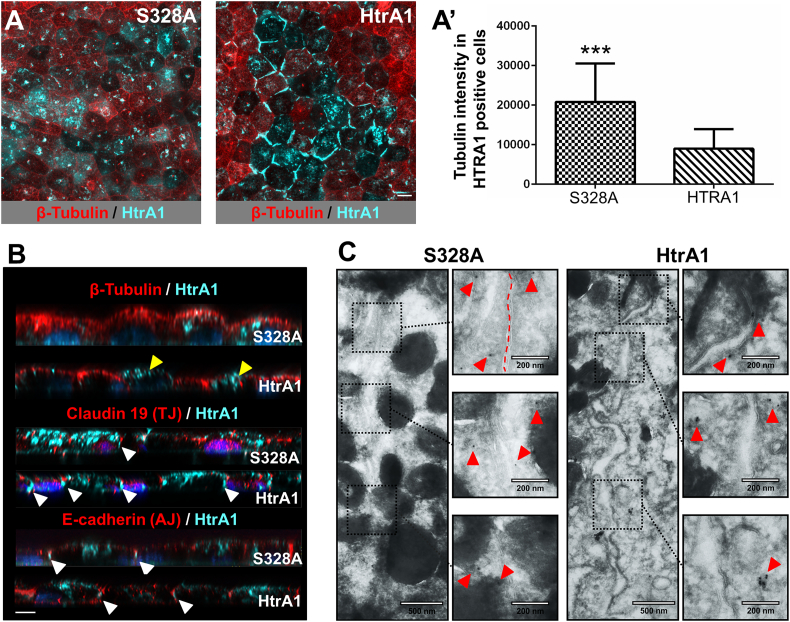
HtrA1 overexpression associates with tubulin loss and localization at the adherens junctions. (A) IF representative confocal image of S328A (left) and HtrA1 (right) overexpressing RPE at day 35 of culture. β-tubulin (red), HtrA1 (cyan) and DAPI (blue); scale bar, 10 μm. (A’) β-tubulin intensity quantification in HtrA1 positive cells at day 35 of culture. Data represent the mean ± SD of three independent experiments, ***p < 0.001. (B) IF high-resolution confocal images (xy plane) of tubulin, claudin-19 and E-cadherin (red) and HrA1 (cyan), DAPI (blue). The apical membrane faces the top. Yellow arrows indicate cells containing less tubulin. White arrows indicate localization of HtrA1 under claudin-19 and co-localization of HtrA1 and E-cadherin. Scale bar, 5 μm. (C) Transmission electron micrographs from immune-gold detection of HtrA1 in S328A, left panel, and HtrA1 overexpressing cells, right panel. Scale bars, 500 nm and 200 nm. Red arrows indicate gold localization. Dashed line indicates the limit between cells.